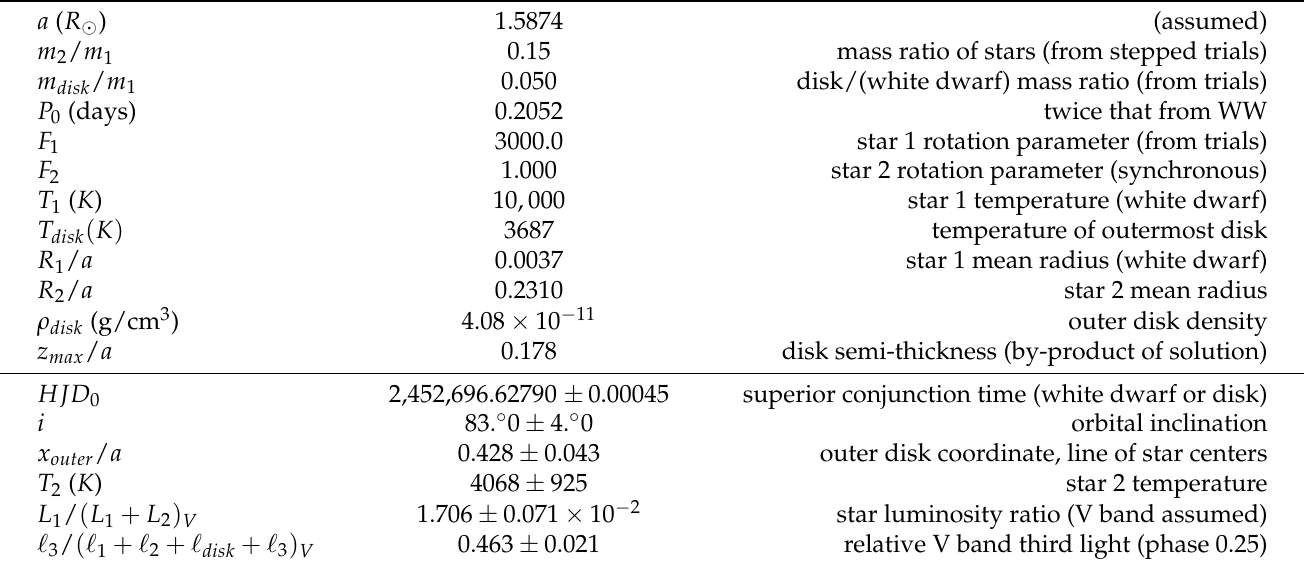
Figure 3. Nights 3 ( left panel) and 4 ( right panel) of IM Nor observing by WW. Night 3 is the one fitted by the method of differential corrections. The depth of star 2’s eclipse by the disk is not reproduced well on night 3, although data within that time interval (HJD 2,452,698.525 to 2,452,698.625) may be strongly affected by a very large upward transient that is wider than the eclipse. The most dramatic transient in WW’s four nights of observing occurred on night 4, when systemic brightness dropped by about ten percent in just three days for reasons unknown. The main objective for now is to see if the eclipse width problem disappears when the orbital period is doubled. This has happened as shown by the figures. Table 1. IM Nor Parameters for Resolution I. Fixed quantities are above the horizontal line and adjusted quantities below the line. HJD 0 refers to superior conjunction of the white dwarf/disk and differs by about a half-cycle of the 0. d 2052 orbit period from WW’s reference time. Their HJD 0 is referenced to the first observed eclipse (considered here to be an eclipse of star 2). The uncertainties are standard errors from the solution. They should not be considered realistic because of the major transients that complicate the IM Nor light variation, although they may be useful as minimum error